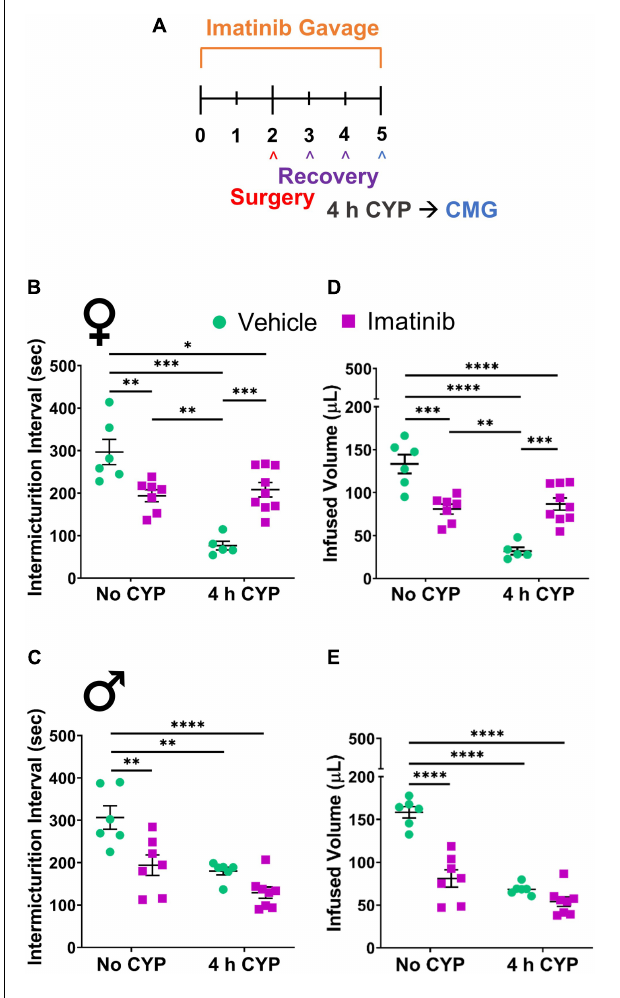
FIGURE 2 | Imatinib mesylate treatment via intravesical infusion significantly increases IMI and IV in an acute (4 h) CYP-induced cystitis mouse model. (A) Acute CYP-induced cystitis (200 mg/kg, 4 h, i.p.) experimental schedule for imatinib mesylate treatment via intravesical infusion (50 µ M, 30 min, 0.5 mL). (B–E) Imatinib treatment via intravesical infusion significantly increases the IMI and IV in female ( p ≤ 0.0001) and male ( p ≤ 0.05) with acute (4 h) CYP-induced cystitis. Imatinib treatment via intravesical infusion significantly increases the IMI and IV in female ( p ≤ 0.01) and male ( p ≤ 0.05) control (no CYP) mice. Control (no CYP) and 4 h CYP treated mice were separate groups of mice, each tested before and after imatinib infusion. n = 6–10. Values are mean ± SEM. ∗ p ≤ 0.05; ∗∗ p ≤ 0.01; ∗∗∗∗ p ≤ 0.0001 by two-way repeated measures ANOVA with Šídák’s multiple comparisons